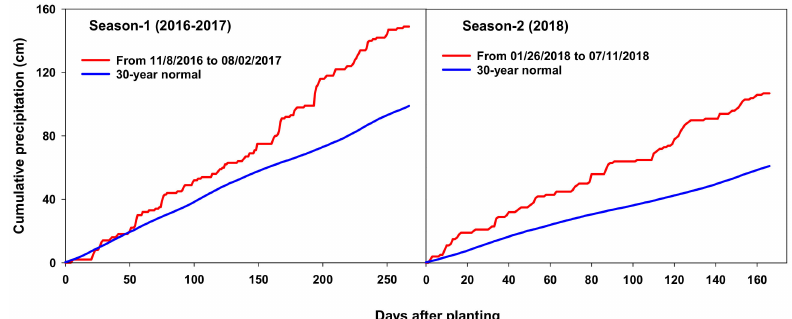
Figure 1. Daily average temperatures from planting through the last day of volumetric soil water content measurement in comparison with the historic temperature data (daily average temperature normal for a period of 30 years from 1981 to 2010).